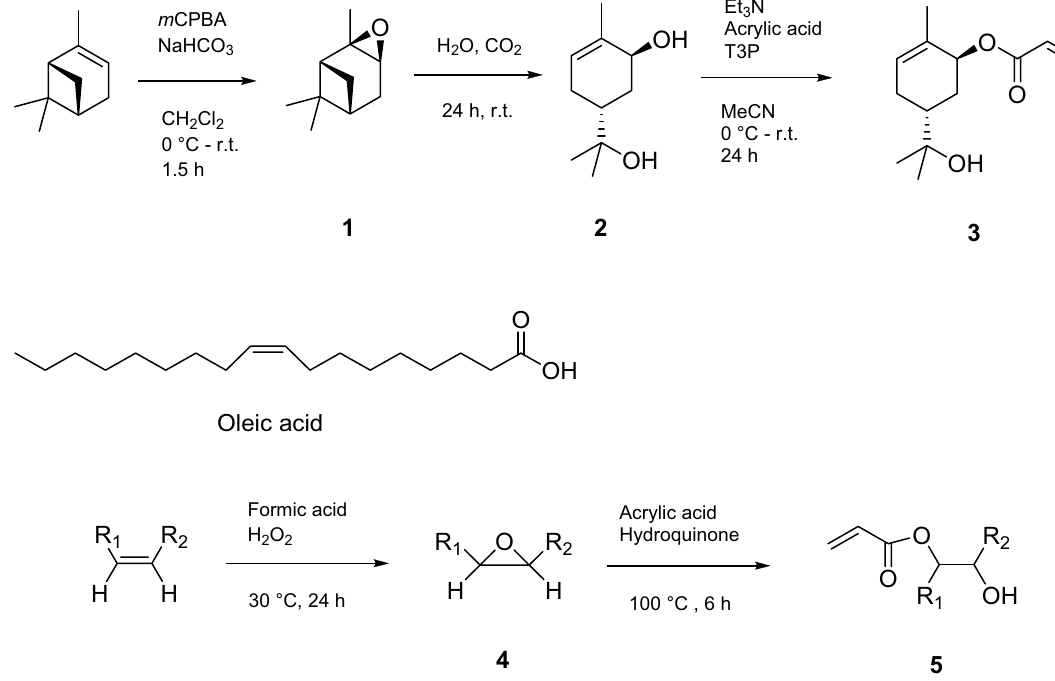
Figure 1. The synthesis routes for the trans -sobrerol acrylate monomer (3) and the acrylated oleic acid monomer